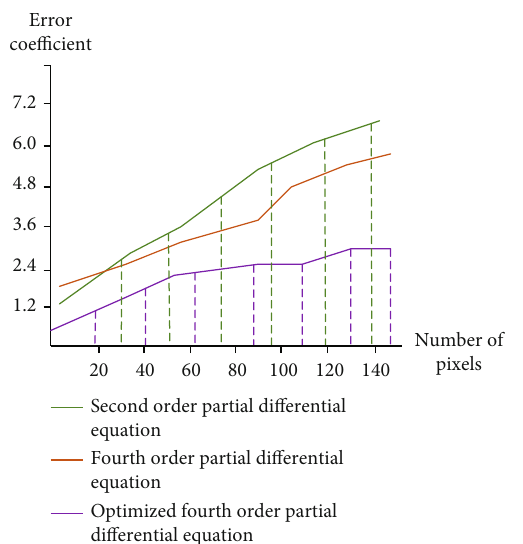
Figure 5: Comparison of PM model, partial di ff erential denoising model, and di ff usion model function.